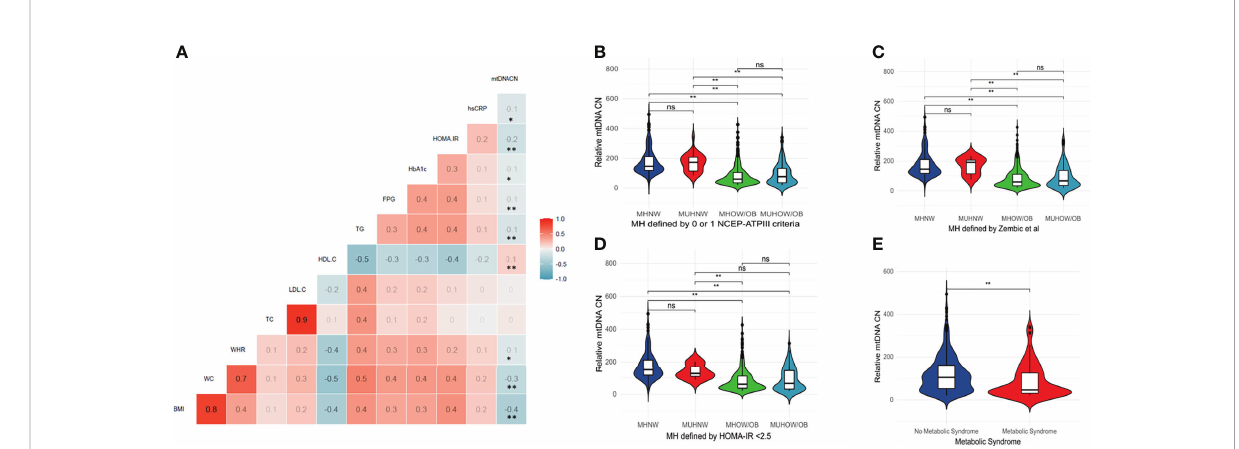
FIGURE 1 (A) Correlation matrix between relative mtDNA copy number and key metabolic parameters – BMI, WC, WHR, TC, LDL-C, HDL-C, TG, FPG, HbA1c, HOMA-IR and hsCRP. Color scale depicts Spearman ’ s rank-order correlation coef fi cient. ** Correlation is signi fi cant at the 0.01 level (2- tailed). * Correlation is signi fi cant at the 0.05 level (2-tailed). (B – E) Violin plots depicting mtDNA CN differences between body composition phenotypes and across different de fi nitions of metabolic health and the metabolic syndrome. A signi fi cantly lower mtDNA copy number was observed in individuals with metabolic syndrome (Mann-Whitney U test, p < 0.05). A signi fi cantly lower copy number was present in both the MHOW/O and MUHOW/O categories, compared to MHNW participants (Kruskal-Wallis test, p <0.001), across different metabolic health de fi nitions. The violin plots re fl ect data distribution. The centerline in the box plot illustrates the medians; box limits indicate the 25th and 75th percentiles; whiskers extend 1.5 times the interquartile range from the 25th and 75th percentiles. ** signi fi cant difference at p < 0.01. NS, not signi fi cant; MHNW, Metabolically healthy normal weight; MUHNW, Metabolically unhealthy normal weight; MHOW/O, Metabolically healthy overweight/obese; MUHOW/O, Metabolically unhealthy overweight/obese; CN, Copy Number; NCEP-ATPIII, National Cholesterol Education Program – Adult Treatment Panel III; FPG, Fasting plasma glucose; TC, Total Cholesterol; BMI, Body mass index; BP, Blood pressure; LDL-C, Low density lipoprotein -cholesterol; HDL-C, High density lipoprotein -cholesterol; TG, Triglycerides; UA, Uric acid; WHR, Waist: Hip